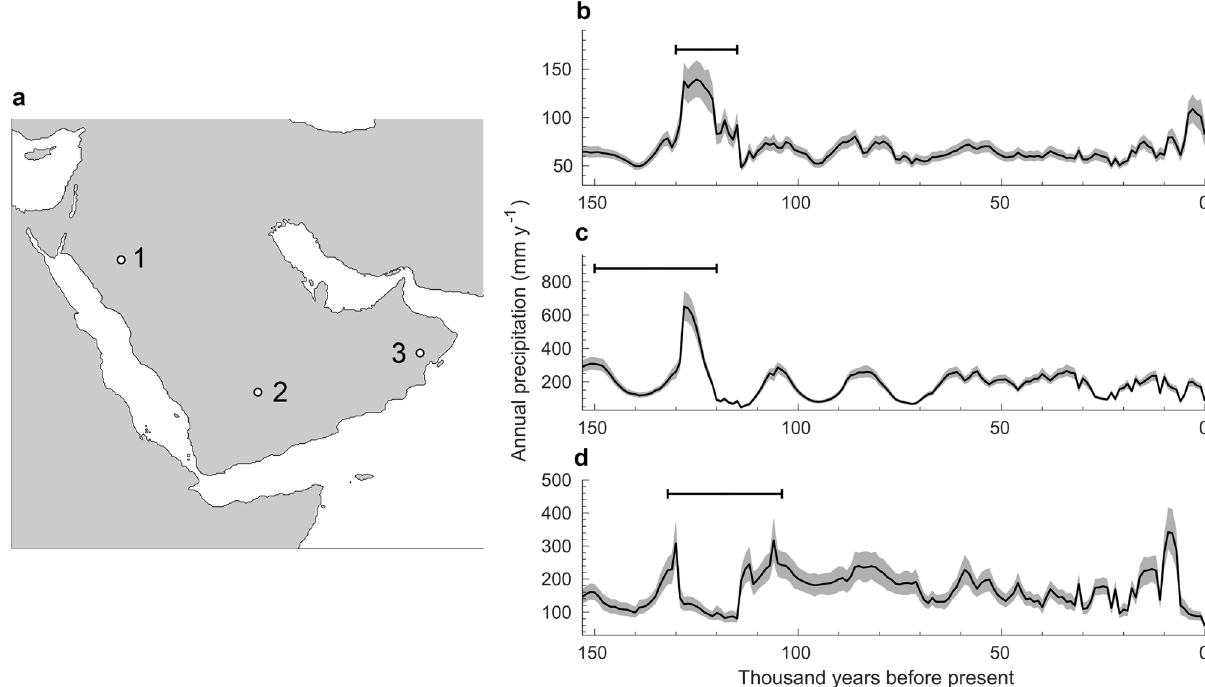
Fig. 6 Comparison of our data against the dates of three palaeolakes on the Arabian peninusla. a Geographical locations of the lakes. b – d Time series of our precipitation data. Black lines represent the simulated climatological normals at 1k-year intervals (Eqs. (2) and (6)), grey shades represent the 10th and 90th percentile of the decadal simulations ( n = 100; Eq. (4)). Horizontal error bars represent the estimated dates of the lakes 24